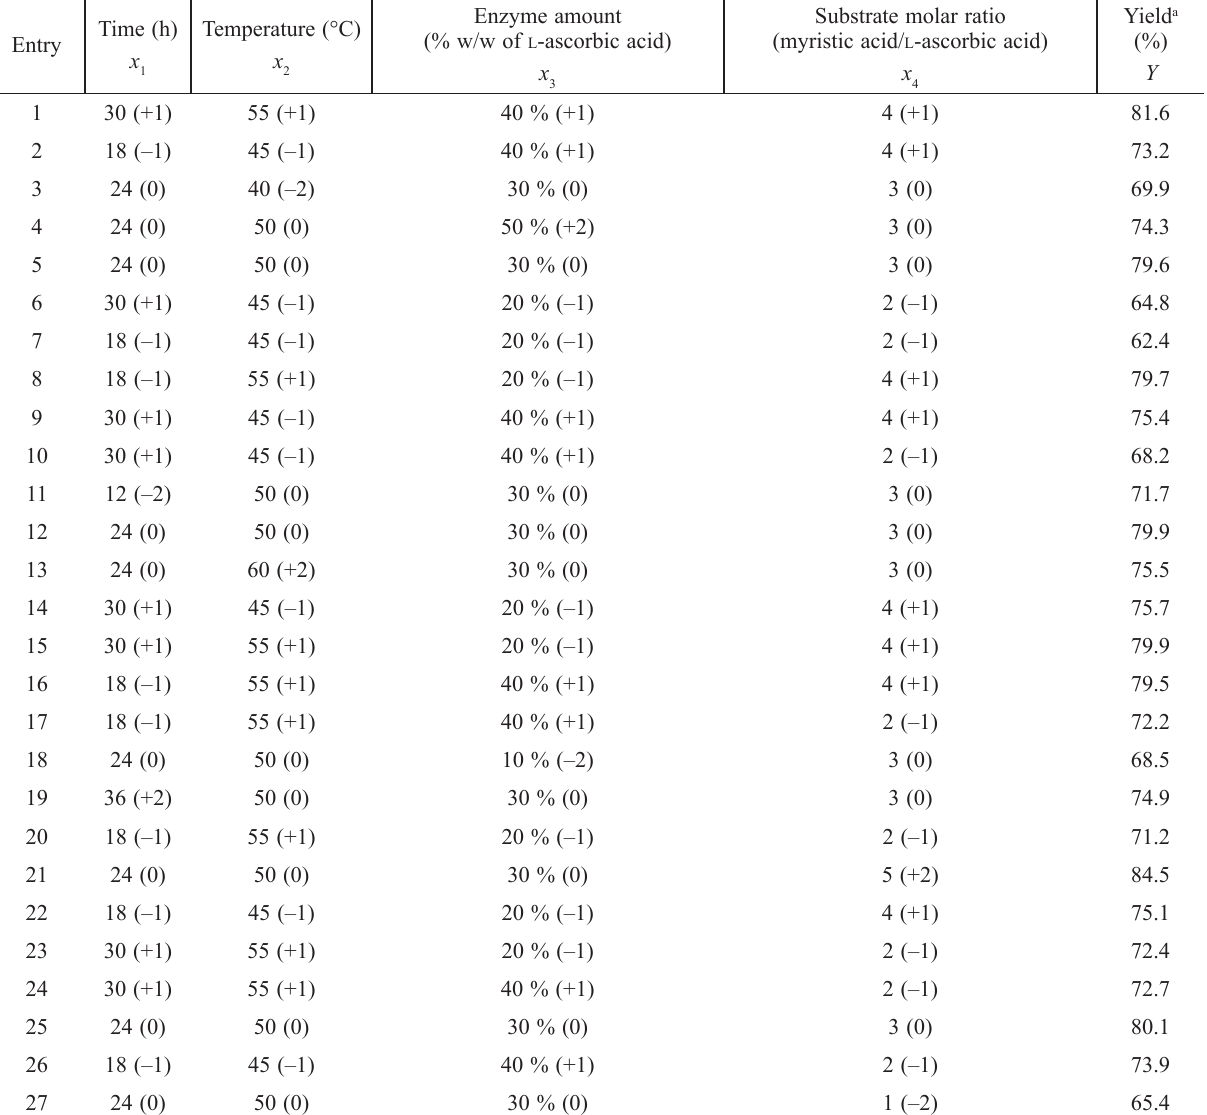
Table 3 – Experimental matrix with code and real values and experimental data for 5-level-4-factor response surface